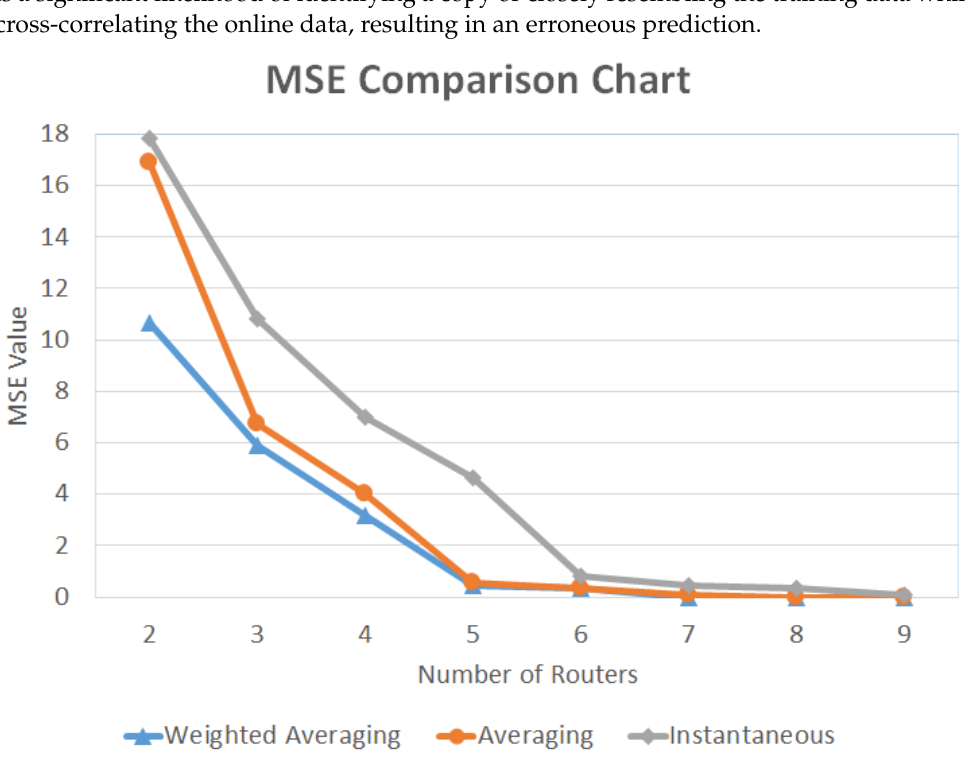
Figure 7. The MSE values employing the three methods as the number of deployed routers is